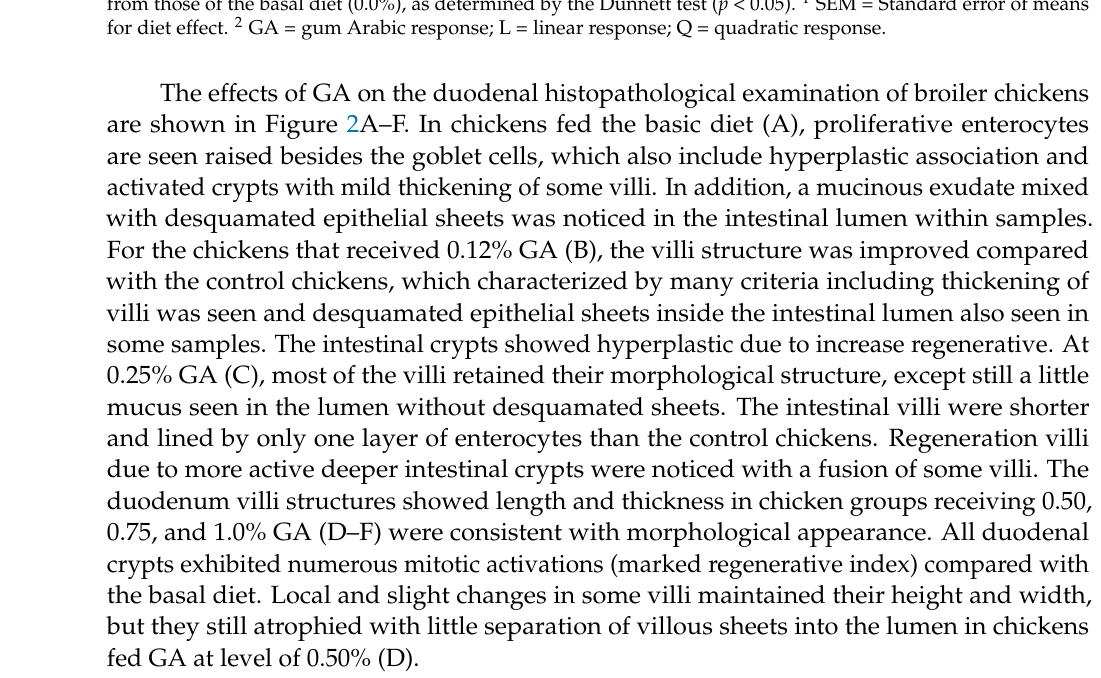
Cecal pH Values Correlation Coefficient r xy